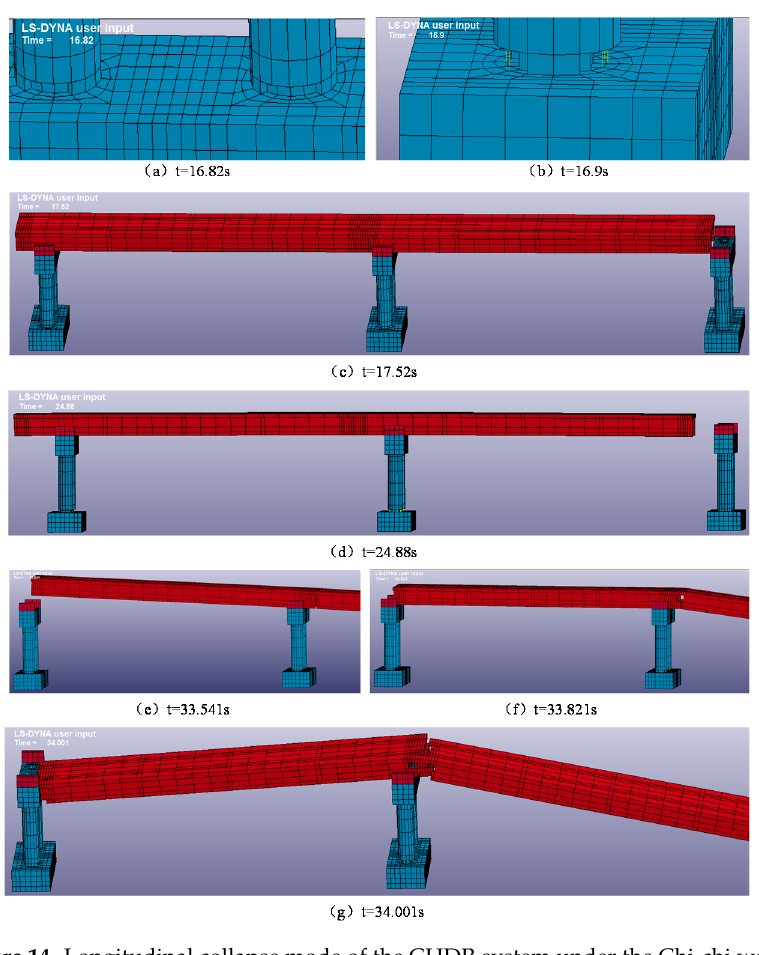
Figure 14. Longitudinal collapse mode of the CHDR system under the Chi-chi wave.